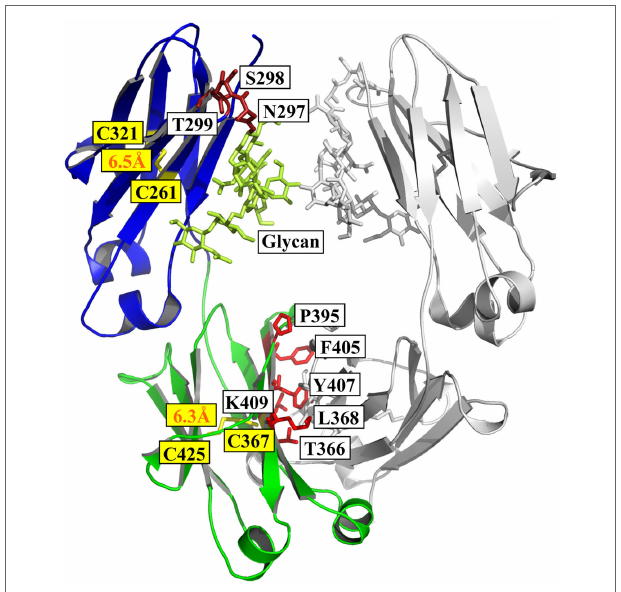
FiGURe 1 | Structure of Fc [PDB 3AVE (47)] presented by PyMOL. The CH2 and CH3 domains are colored by blue and green, respectively; the residues (N297, S298, and T299) in glycosylation motif in CH2 are colored dark red; the residues (T366, L368, P395, F405, Y407, and K409) involved in the interactions between two CH3 domains are colored by light red; and the oligosaccharides and native disulfides are colored by lemon and yellow,